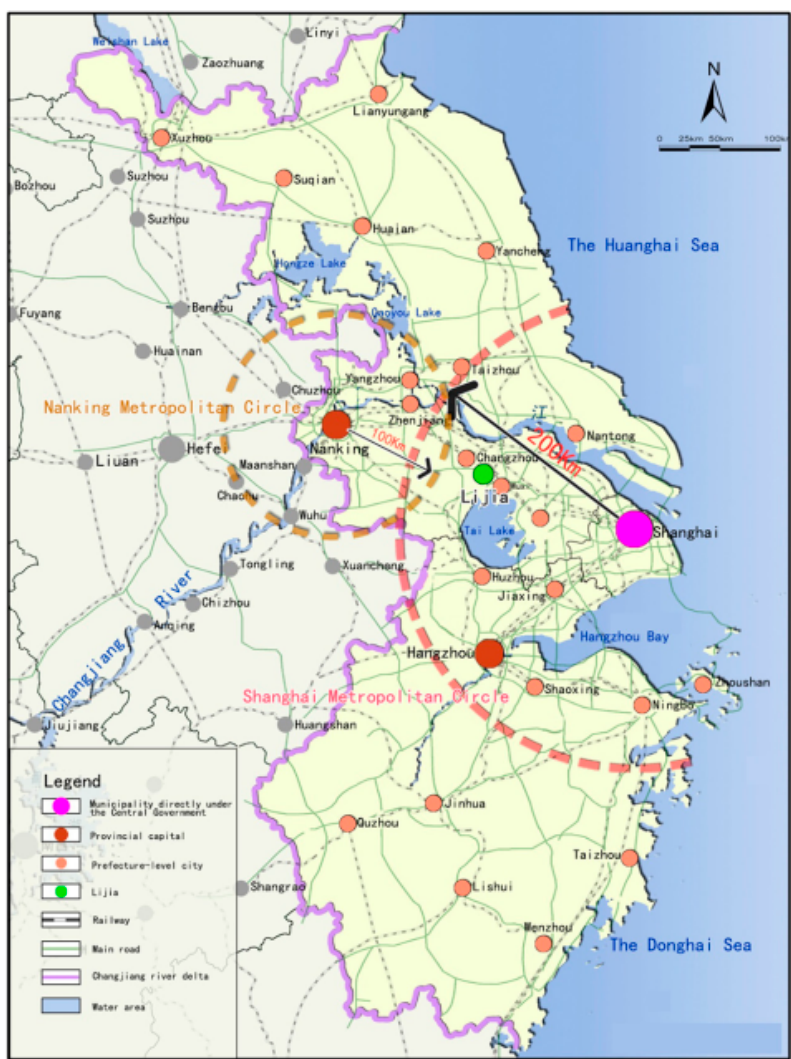
Figure 2. The location of Lijia on the fringe of the metropolitan region.